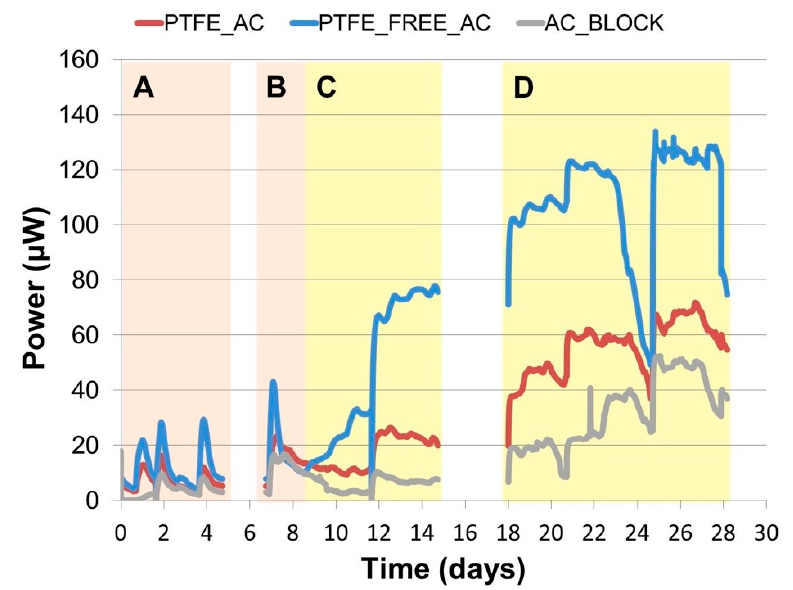
Figure 1. Real time power output of the MFCs employing different cathode electrodes. Different phases are annotated. ( A ) Inoculation phase consisting of three sludge exchanges as indicated from the spikes in the graph; ( B ) Single re-inoculation following a 48 h of power cut and loss of data; ( C ) Initiation of urine feeding cycle; ( D ) Continuation of urine feeding cycle following a 79 h period without monitoring.